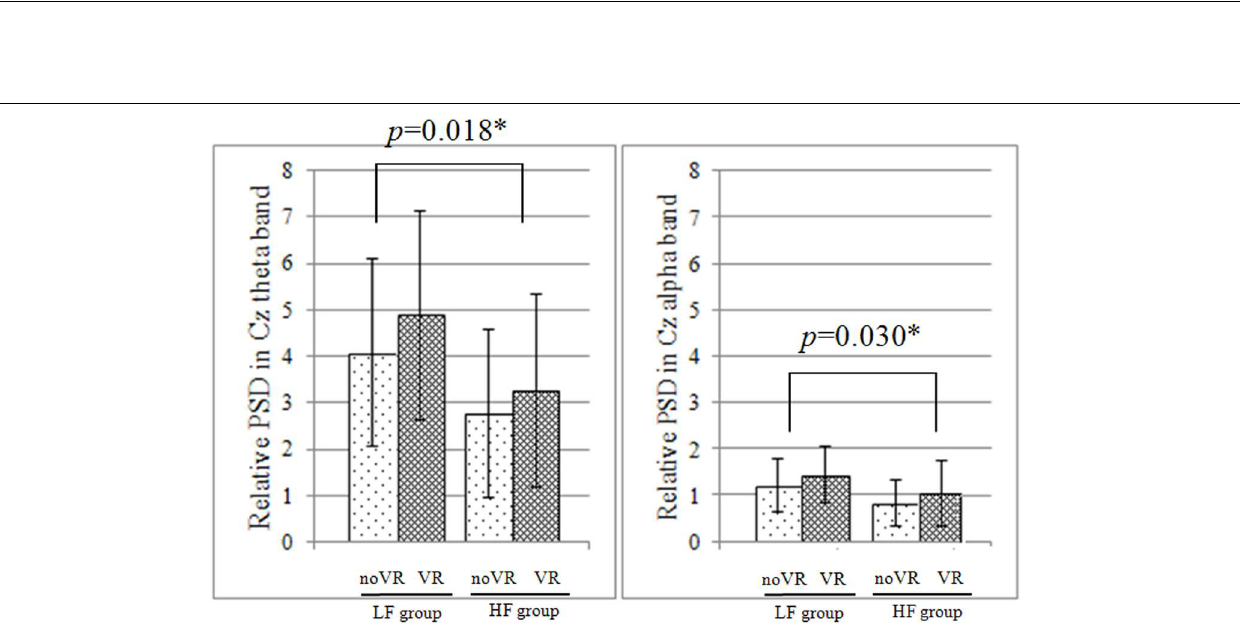
FIGURE 3 | Relative PSD at Cz during the initial platform slip forward phase. In both the theta and alpha band, there was no significant interaction between vision × group factors, but there was a significant simple main effect of the group factor based on the data from Cz; furthermore, the low fall-risk potential (LF) group had significantly higher power spectrum density (PSD) than the high fall-risk potential (HF)